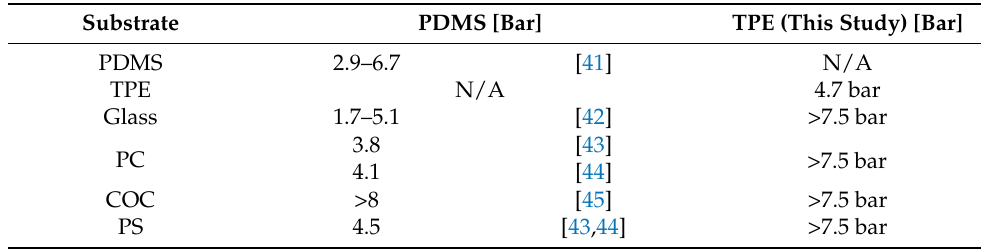
Table 1. Maximum working pressures of PDMS- and TPE-based bonding to various substrates. Burst pressures from literature are converted to bar and rounded. TPE values (from this study) are average, maximum pressures of non-activated samples at day